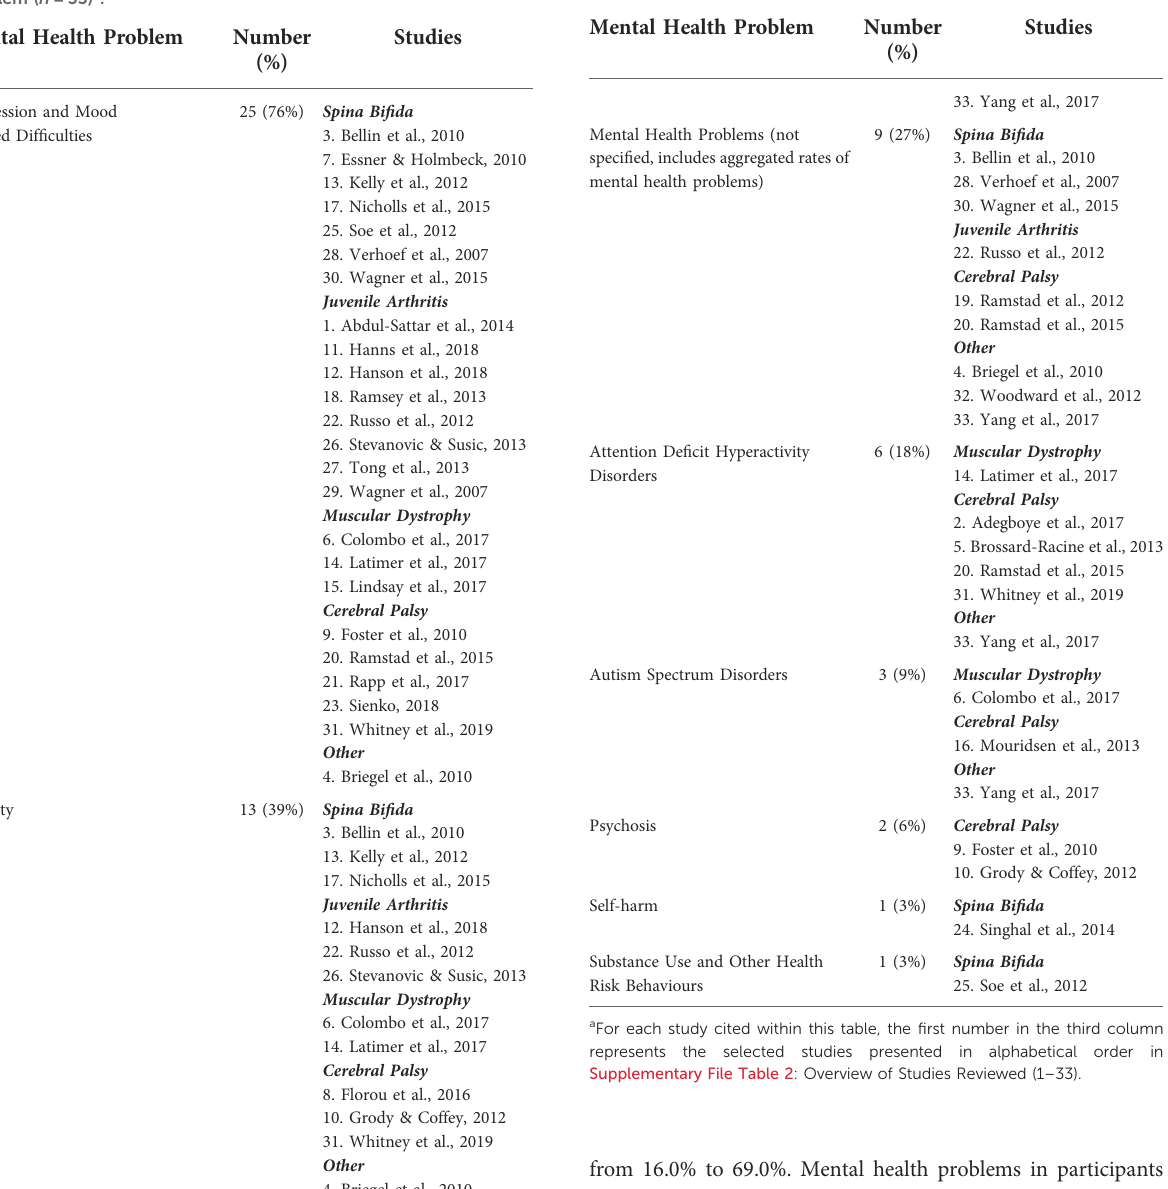
TABLE 3 Number of articles addressing a speci fi c mental health problem ( n =33) a